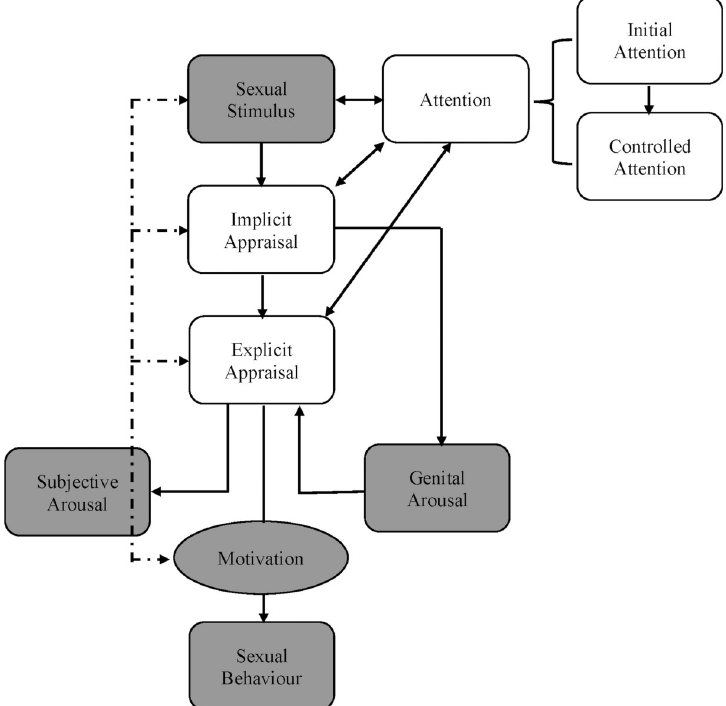
Fig 1. Cognitive-motivational model of sexual response. Adapted from DeWitte [25] and Janssen and colleagues [26].